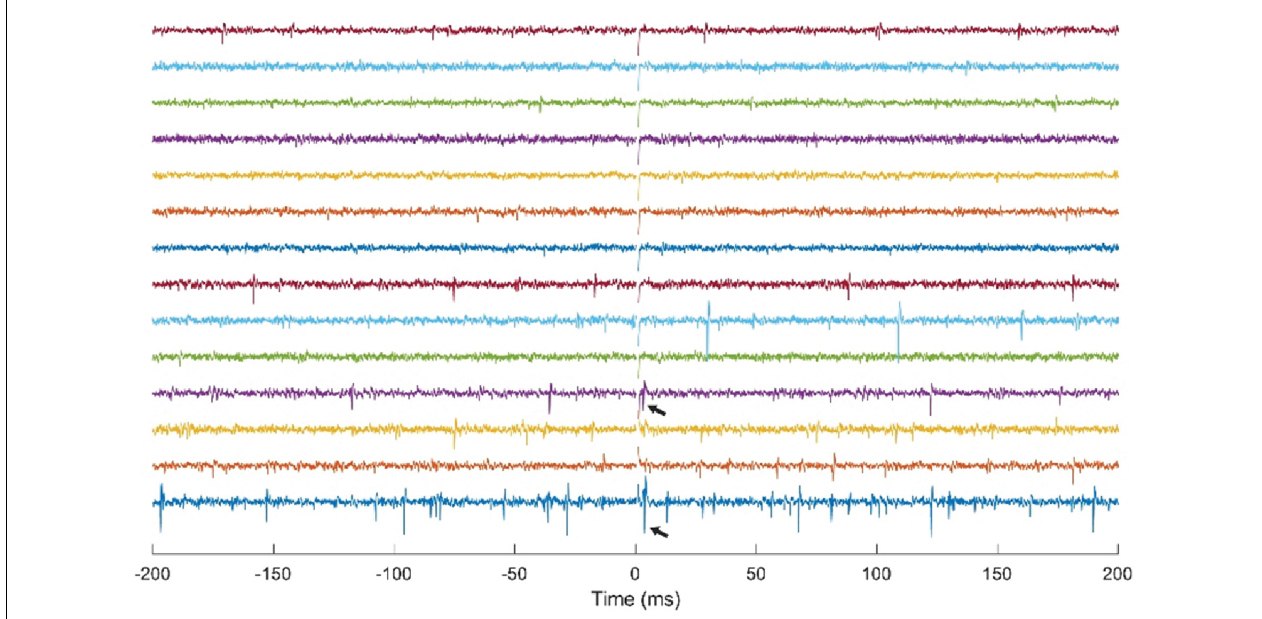
FIGURE 8 | Simultaneous stimulation and multichannel recording of neural action potentials with NC3. Stimulus occurs at t = 0. Arrows indicate action potentials evoked by a 15 µ A stimulus delivered through a neighboring electrode.